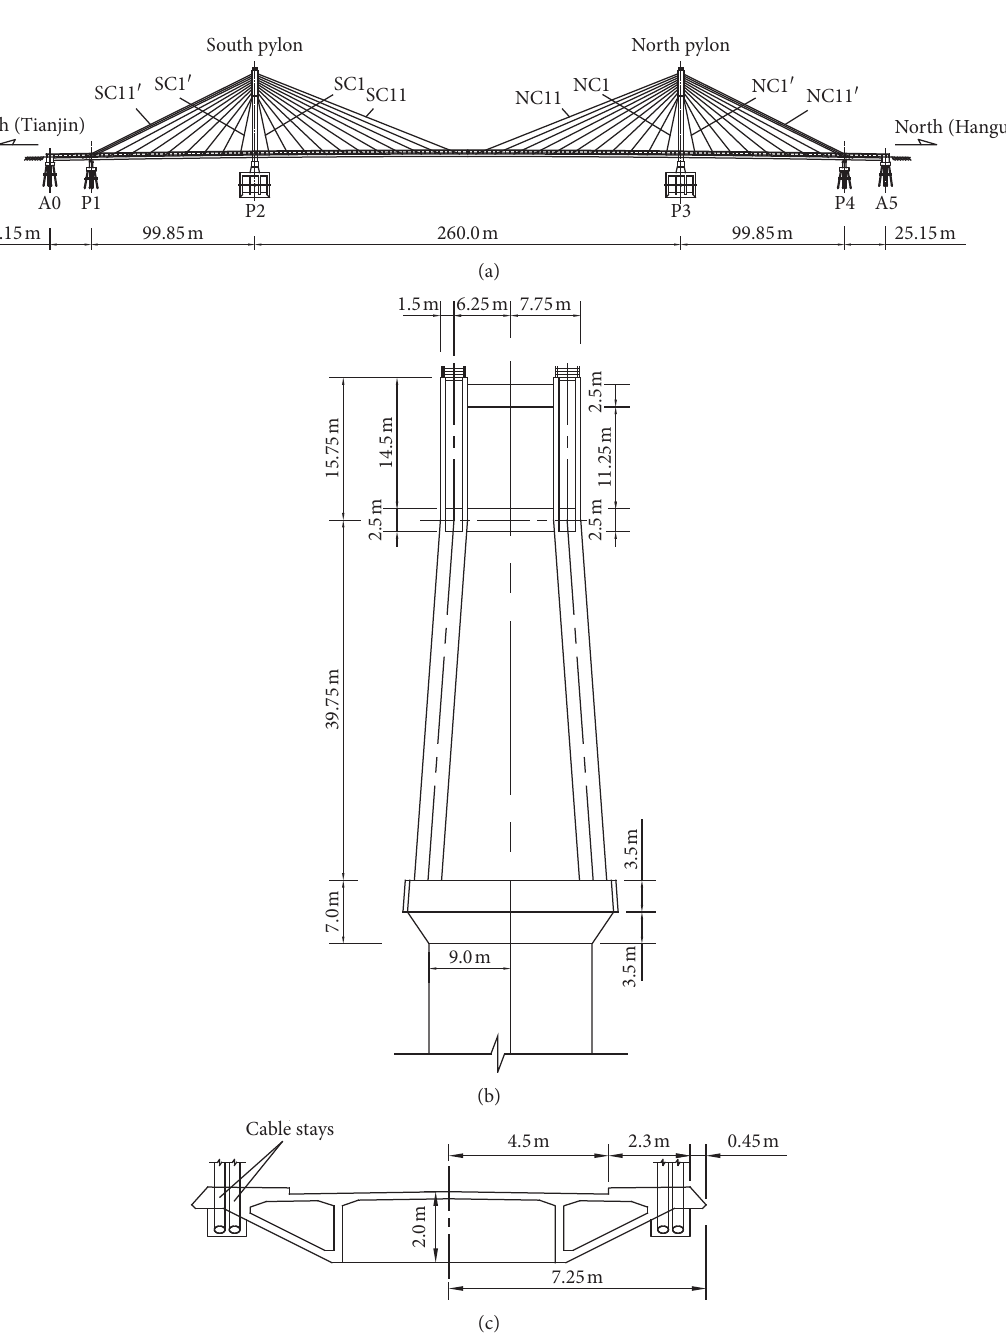
Figure 2: General view of Yonghe Bridge: (a) elevation; (b) side view and details of tower; (c) typical cross section of main girder.